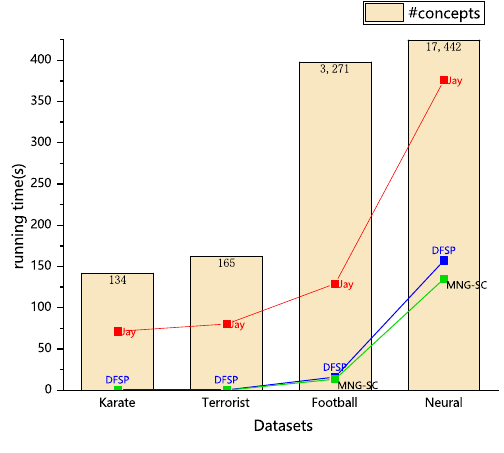
Figure 4. The number of generated concepts and the running time of Jay, DFSP and MNG-SC on the experimental